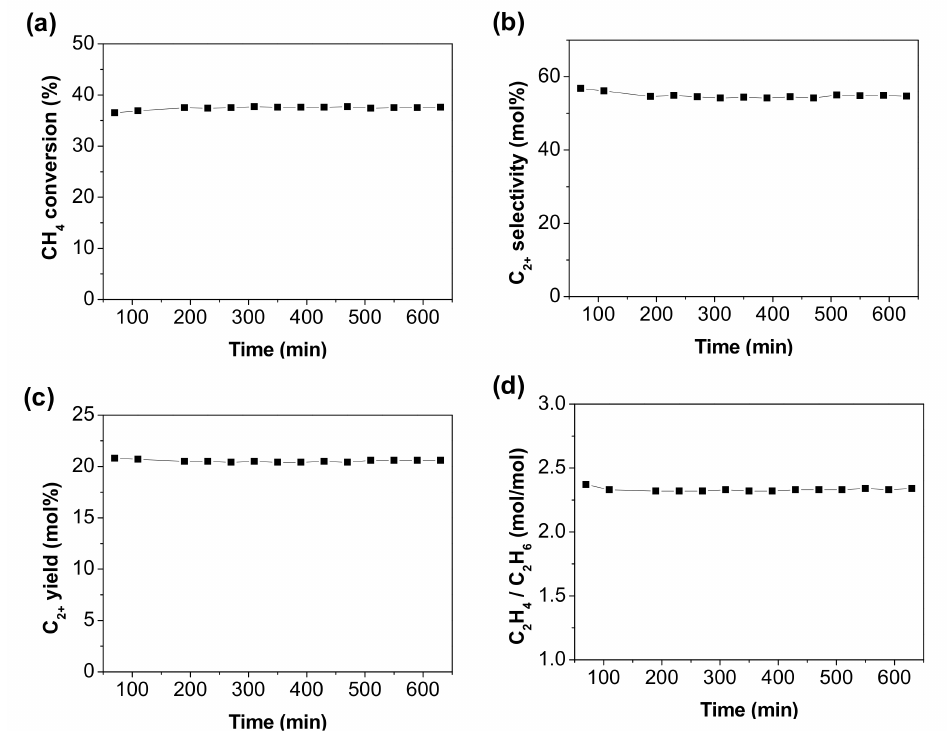
Figure 5. The catalytic activity for OCM reaction over MNW / m-SiC catalyst at 800 ◦ C with time-on stream. ( a ) CH 4 conversion; ( b ) C 2 + selectivity; ( c ) C 2 + yield; and ( d ) C 2 H 4 / C 2 H 6 ratio (feed composition: